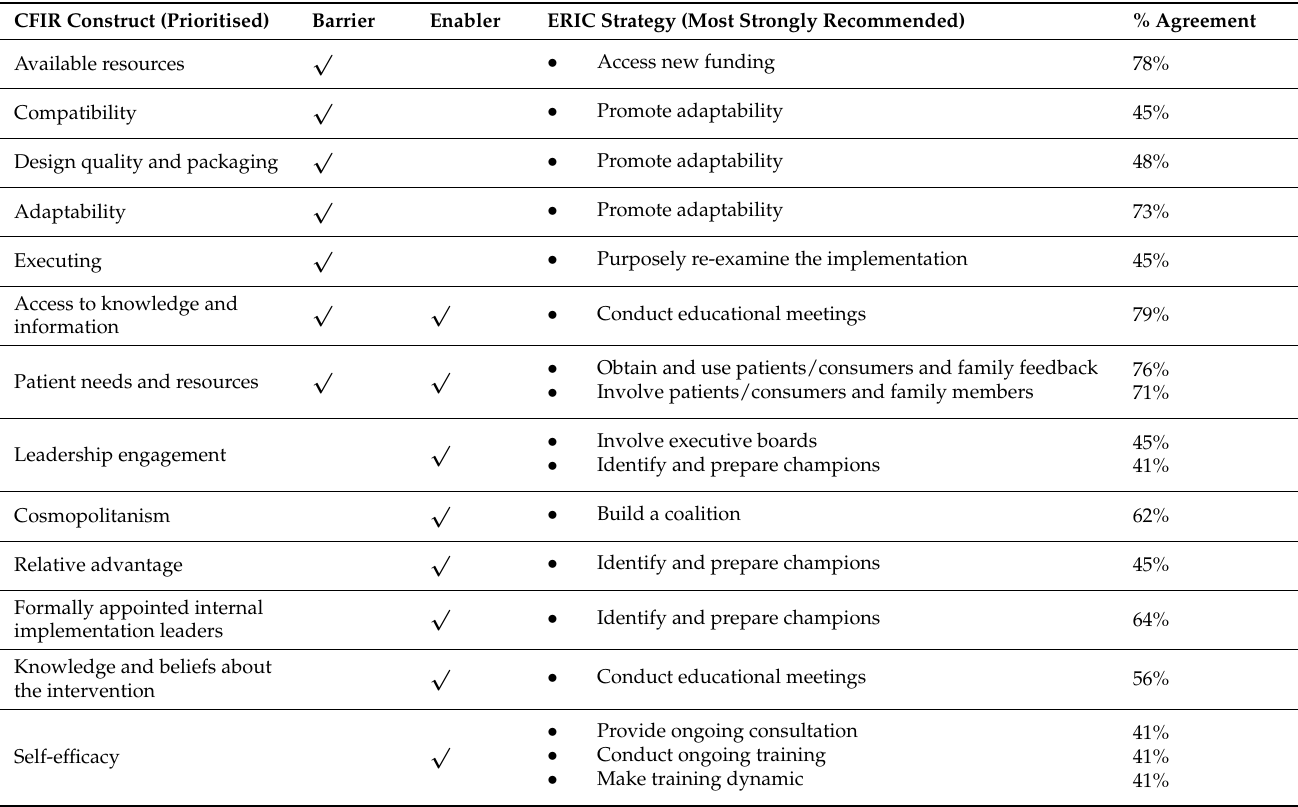
Table 4. Summary of enabler and barrier constructs mapped to ERIC strategies.